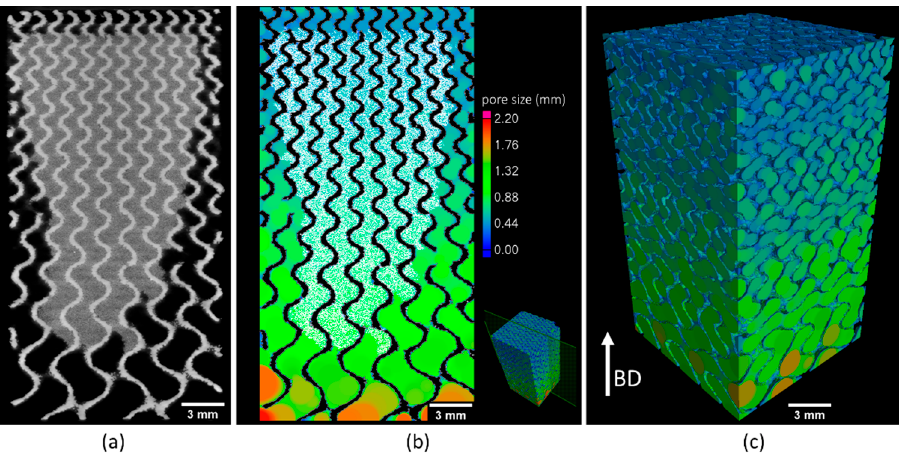
Figure 12. ( a ) 2D slice of a 3D reconstruction of a FGPS structure; ( b ) 2D slice showing the result of 3D pore size analysis (the white area represents the entrapped powder particles); ( c ) 3D rendering of the pore size distribution along the build direction (BD).